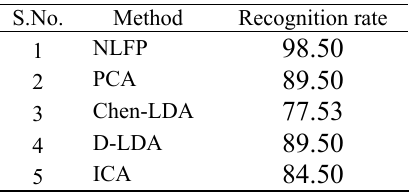
Table 3. Comparison of NLFP method with other popular methods reported